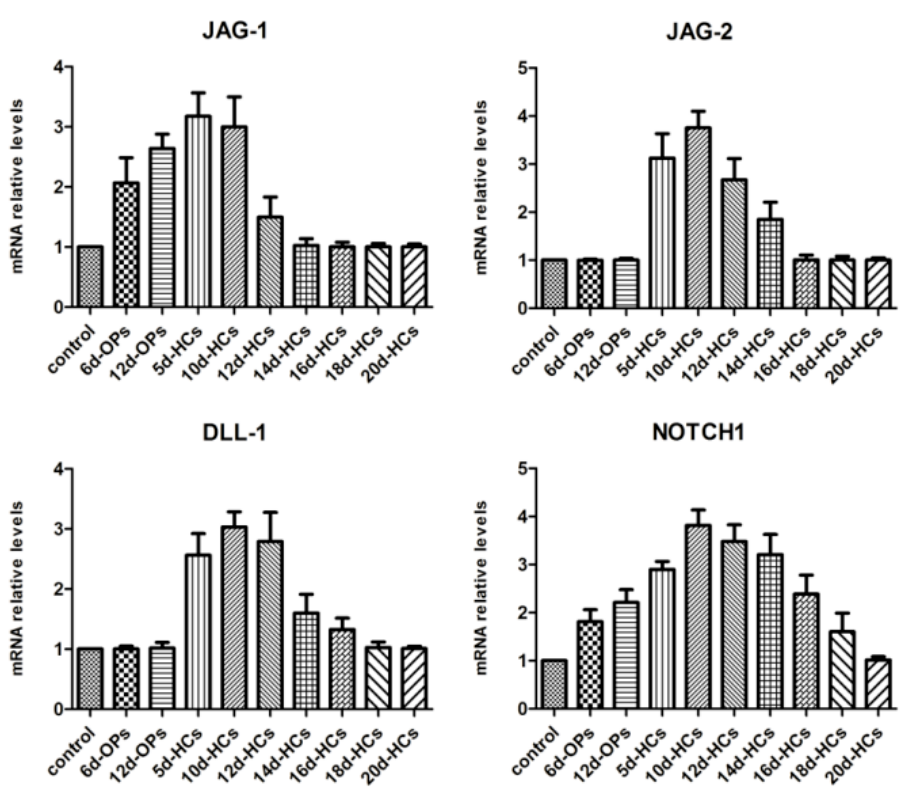
Figure 1. The expression pattern of Notch ligands and receptors. The expression of JAG-1 and NOTCH1 mRNA was gradually upregulated throughout the otic progenitor differentiation, whereas JAG-1 was downregulated during the mid-stage (day 14) and NOTCH1 was downregulated in the final stage (day 20) of hair cell differentiation. JAG-2 and DLL-1 mRNAs were detected at the early stage of hair cell differentiation, but their expression was downregulated by the mid-later stage of the differentiation. The statistical results were significant ( p < 0.05). Control: undifferentiated hESCs; 6d-OPs/12d-OPs: cells on day 6/12 of otic progenitor differentiation; 5d-HCs/10d-HCs/12d-HCs/14d-HCs/16d-HCs/18d-HCs/20d-HCs: cells on day 5/10/12/14/16/18/20 of hair cell differentiation. 2.2. The Effects of ShRNA Silencing on the Expression of Target Genes Three series of lentiviral shRNA vectors (JAG-1-shRNA 1-4, JAG-2-shRNA 1-4, and DLL-1-shRNA 1-4) and one negative control vector (NC-shRNA) were constructed to determine the shRNA species with silencing efficiency for vectors. JAG-1-shRNA 1-4 vectors were used to infect cells on day 12 of otic progenitor differentiation, whereas JAG-2-shRNA 1-4 and DLL-1-shRNA 1-4 vectors were separately used to infect cells on day 5 of hair cell differentiation. The results of qRT-PCR showed that JAG-1, JAG-2, and DLL-1 in control (no transfection) and NC-shRNA transfected cells were expressed at the same levels ( p > 0.05). The expression of JAG-1, JAG-2, and DLL-1 in cells transfected with JAG-1-shRNA 1-4, JAG-2-shRNA 1-4, and DLL-1-shRNA 1-4 vectors was downregulated relative to that of the control ( p < 0.01), which had the highest silencing efficiency of their corresponding genes (Figure S1). Therefore, JAG-1-shRNA2, JAG-2-shRNA4, and DLL-1-shRNA3 vectors were chosen for subsequent stable infection. After culturing in monolayers with otic progenitor-induction conditions for 10–12 days, hESCs can differentiate into OEPs and ONPs. The OEPs were separated, and hair cell differentiation was induced for 3–4 weeks. To examine the effects of Notch signaling on the in vitro differentiation of hair cell-like cells, lentivirus (pAJ-U6-shRNA-CMV-Puro/GFP) -expressing JAG-1-shRNA2, JAG-2-shRNA4, or DLL-1-shRNA3 was used to infect cells at different stages of differentiation. Six infection schemes were performed according to the aforementioned Notch ligand expression patterns, which included: